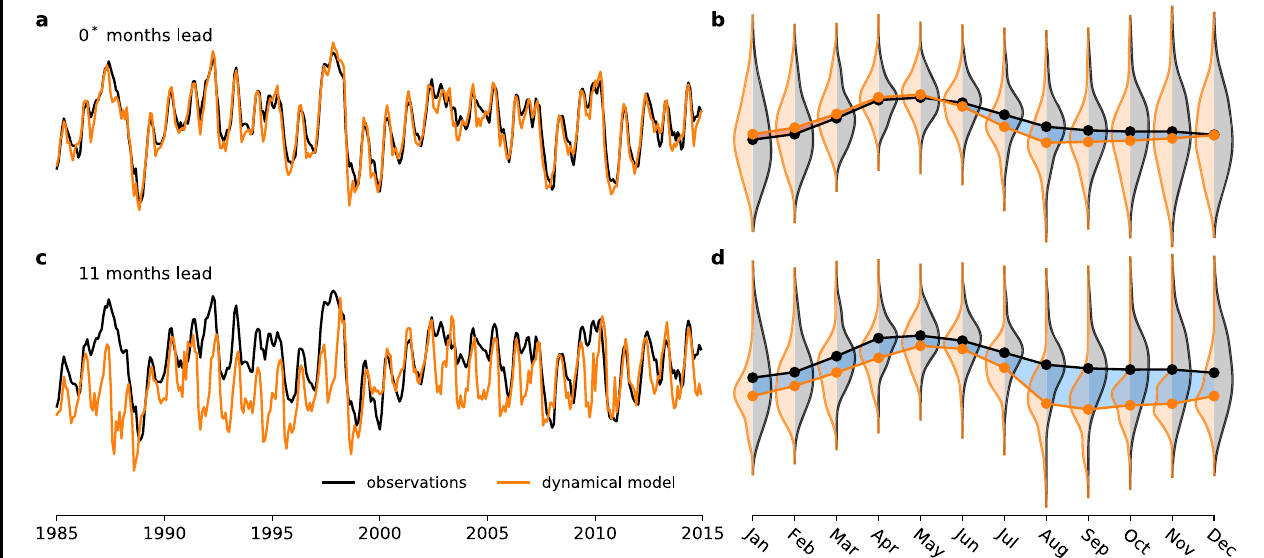
Fig. Box 1: Model bias schematic. Panels a and c show Niño3.4 temperature for observations and the aer04 model ensemble mean at lead 0 * (the start of the forecast) and after 11 months, for a sequence of forecasts issued a month apart. The observations values are simply the time series of Niño3.4 temperature and are identical at lead 0* and lead 11. The model values at lead 11 are the values predicted by forecasts initialised 11 months prior to the time shown. The panels b and d show the distribution of lead 0* and lead 11 values for the model and observations for each calendar month. These are again identical for observations, but change for the model. The dots on these plots show the mean of the